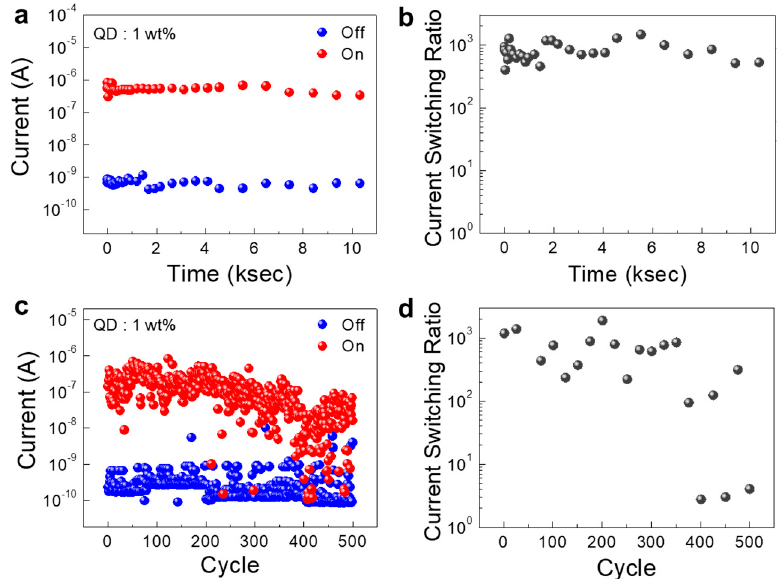
Figure 4. ( a ) The data retention characteristics of the CdSe/ZnS QD-PMMA memristor (QD: 1wt%). The LRS and HRS states were programmed with biases of +3 V and − 3 V, respectively. Additiaonally, the V read was +1 V. ( b ) The variation of current switching ratio during the data retention test up to 10 4 s. ( c ) The endurance cyclic test data of the CdSe/ZnS QD-PMMA memristor (500 cycles). The LRS and HRS states were programmed with biases of +3 V and − 3 V, respectively. Additionally, the V read was +1 V. ( d ) The variation of current switching ratio during the endurance test.